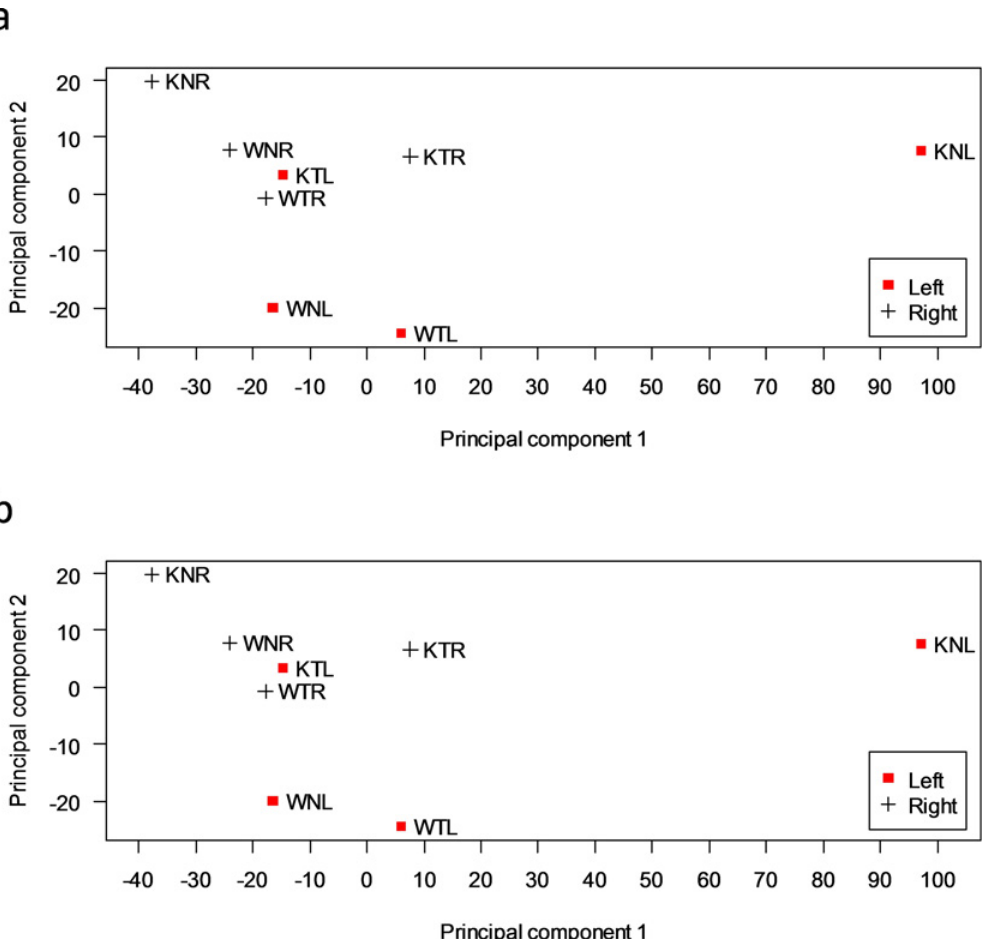
Fig 4. Principal component analysis (PCA) is used to cluster the conditions with gene expression levels for (a) all genes, (b) 5282 genes that are differentially expressed in at least one of comparisons listed in Table 1. Each point corresponds to the gene expression pattern generated by an experimental group projected onto the two-dimensional principal component